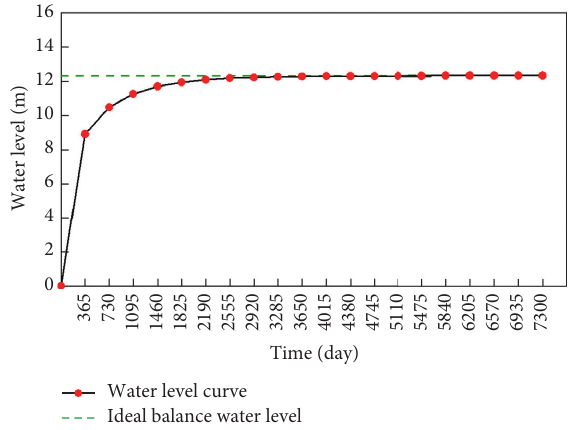
Figure 8: Water level fluctuation when continuous rainfall enters the reservoir under the extreme conditions all the